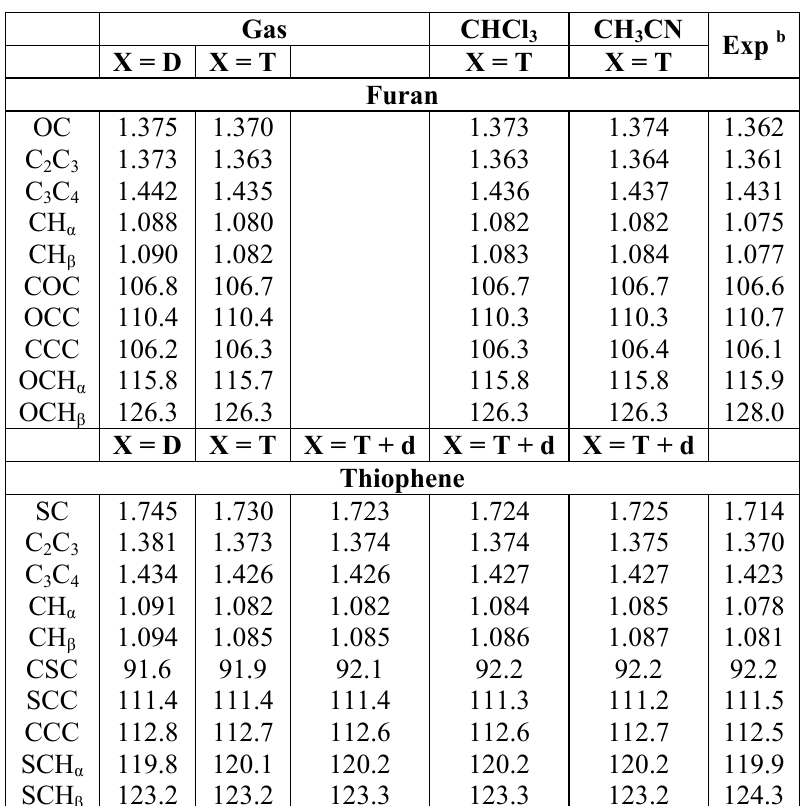
Table 1. C symmetry restricted optimized geometries at the B97D/aug-cc-pvXz level for 2v furan and thiophene a